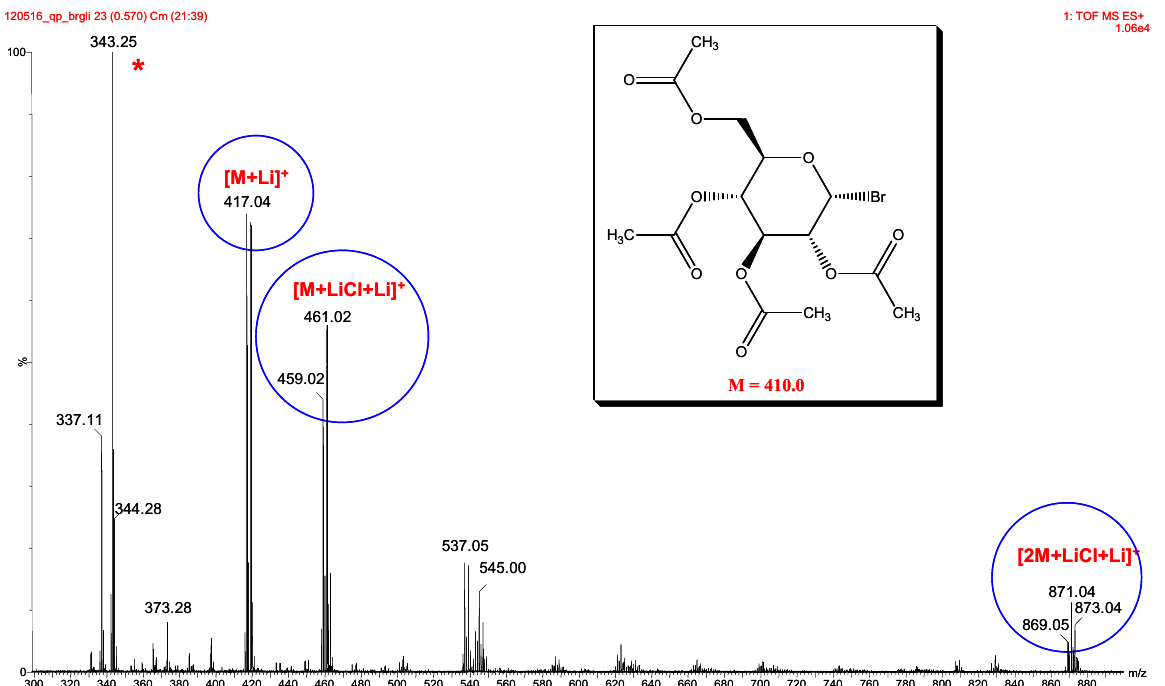
Figure 3. Mass spectrum of analyte glycosyl bromide 2 (* indicates an unidentified